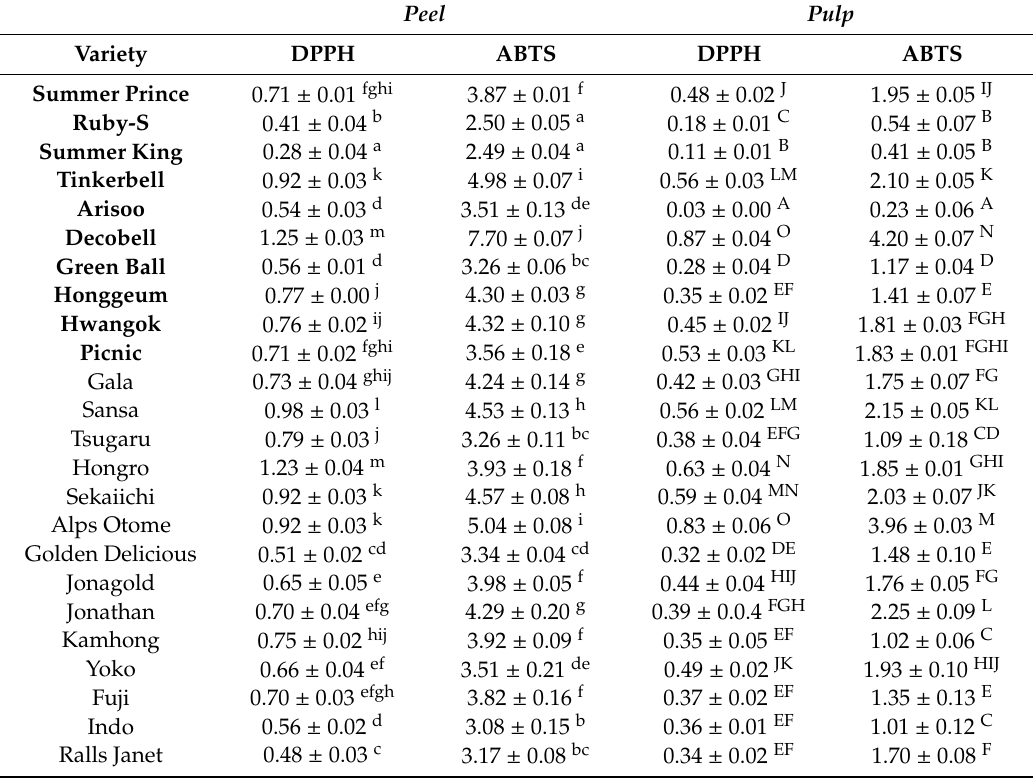
Table 2. Antioxidant activities (mg Trolox equivalent / g DW) of apple peel and pulp.